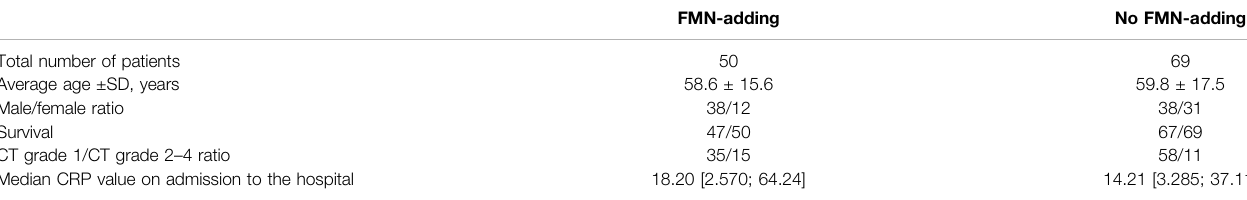
TABLE 1 | General characteristics of studied